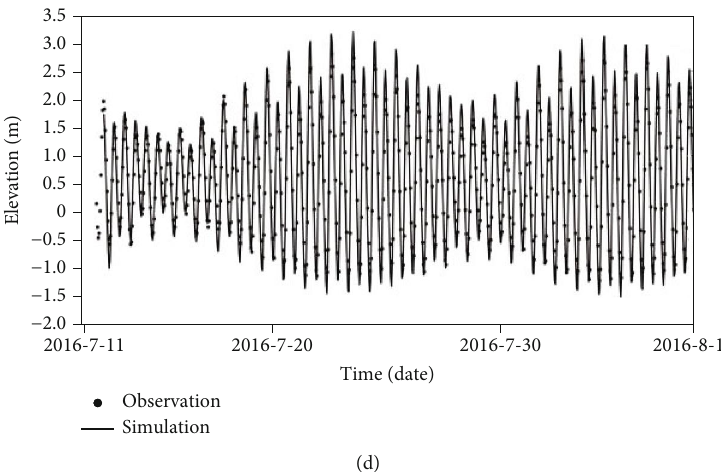
Figure 5: Comparison of simulated and observed tidal levels in the Yangtze River Estuary. (a) Shidongkou. (b) Jigujiao. (c) East of Nanchao. (d) Middle of Bei